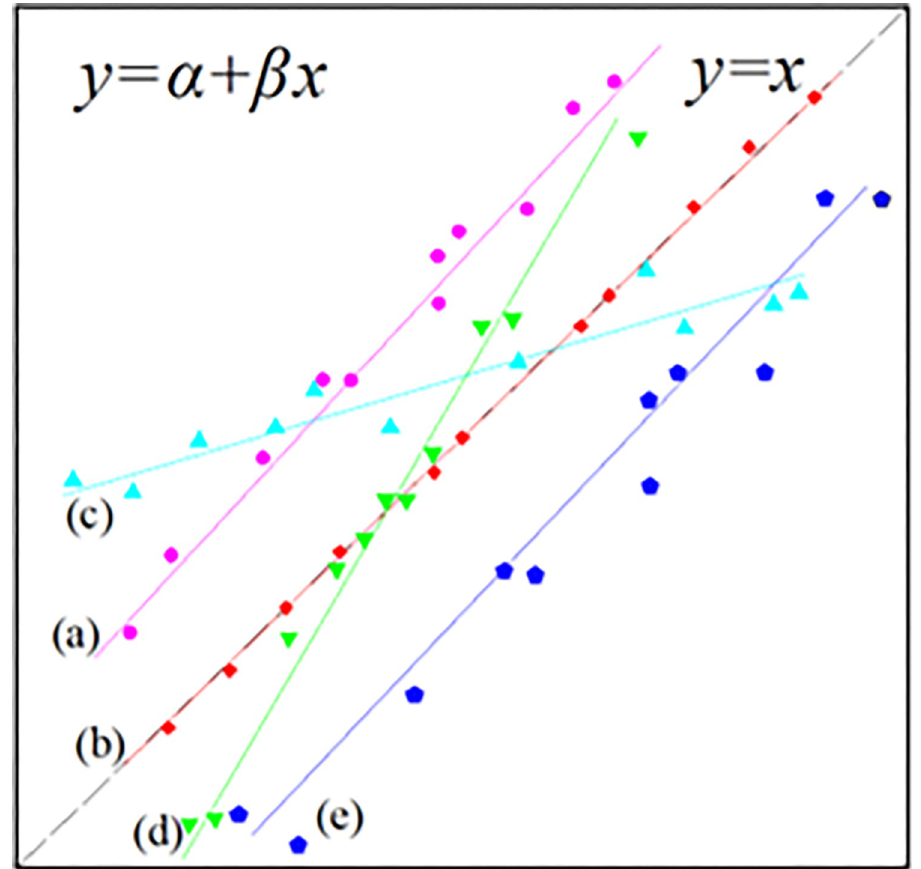
Fig 2. Distribution types generated by the power law model [17]. (a) Patchy distribution or cluster distribution, (b) random distribution, (c and d) some species had a patchy distribution, and some species had a uniform distribution, (e) uniform distribution. y = x line shown as dashed grey line [mostly overplayed by (b)]